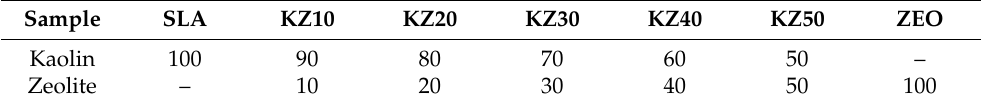
Table 2. The compositions of the samples made from Sedlec kaolin and natural zeolite (in mass%). Sample